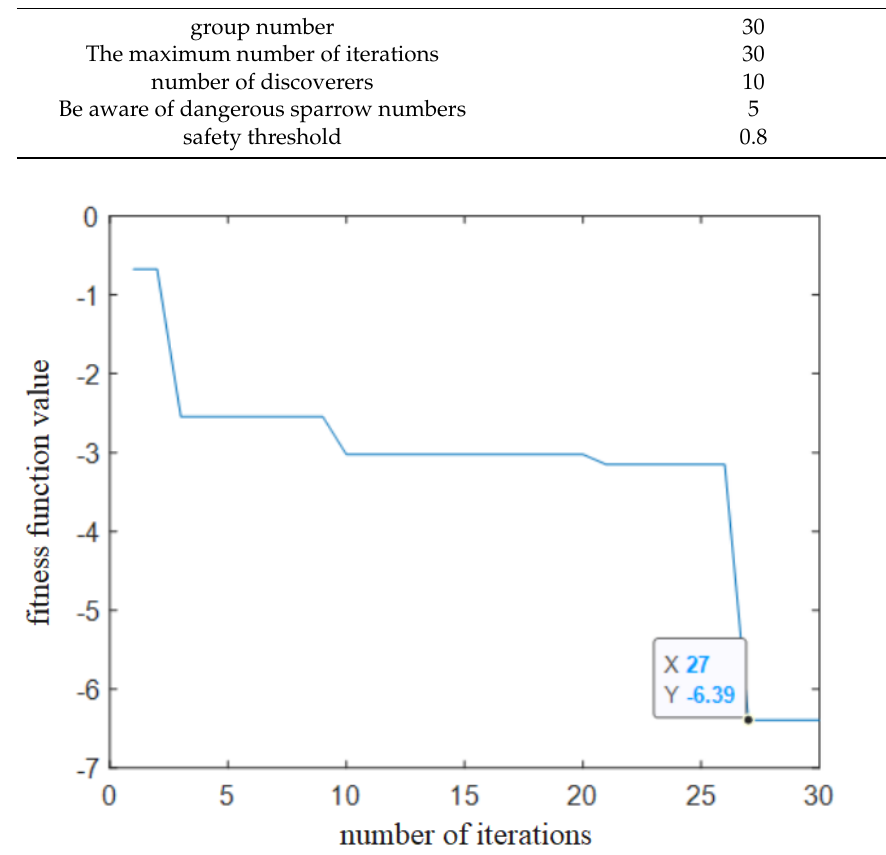
Figure 5. Fitness function curve of the simulated inner ring signal.